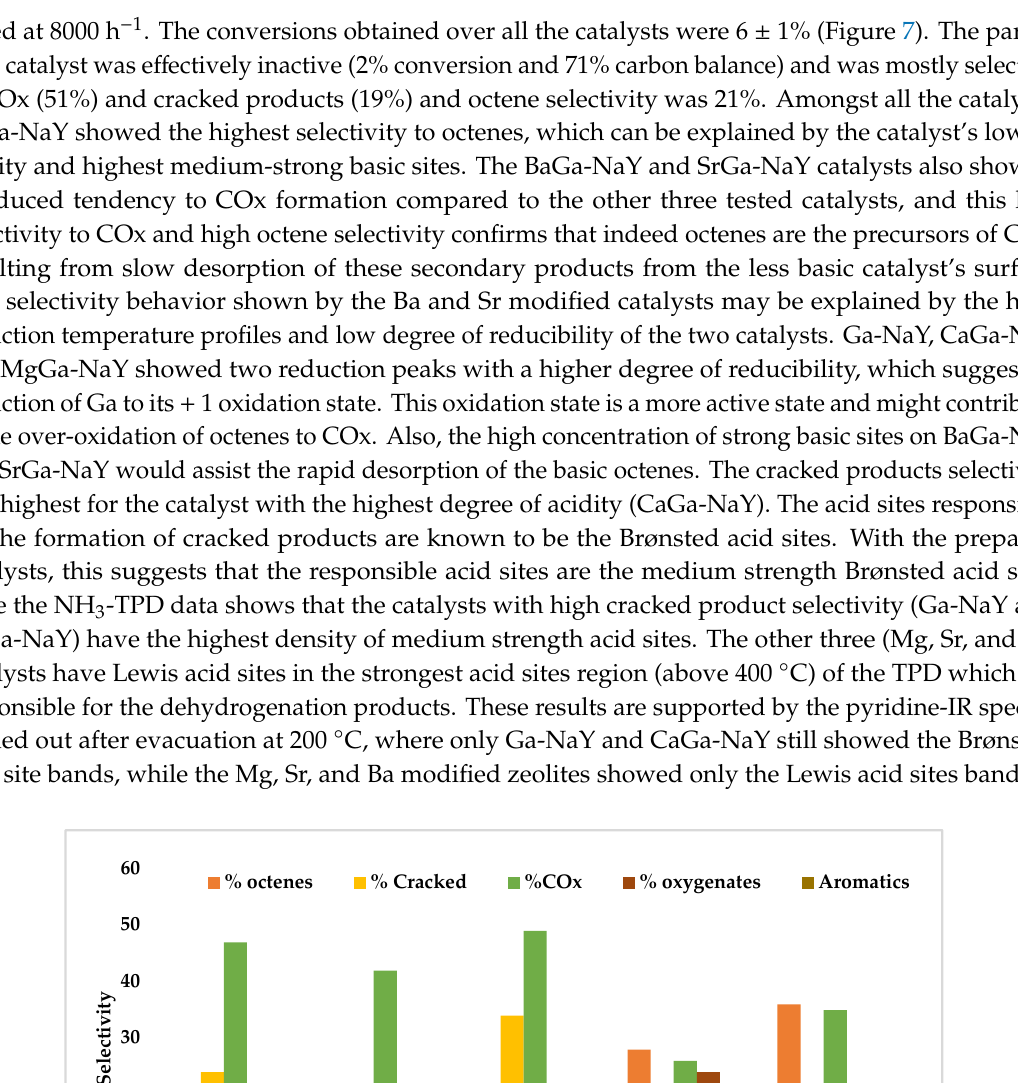
Figure 8. Selectivity towards different cracked products, at iso ‐ conversion (6 ± 1%) of n ‐ octane at a fixed temperature of 450 °C. 3. Materials and Experimental Methods 3.1. Catalysts Preparation